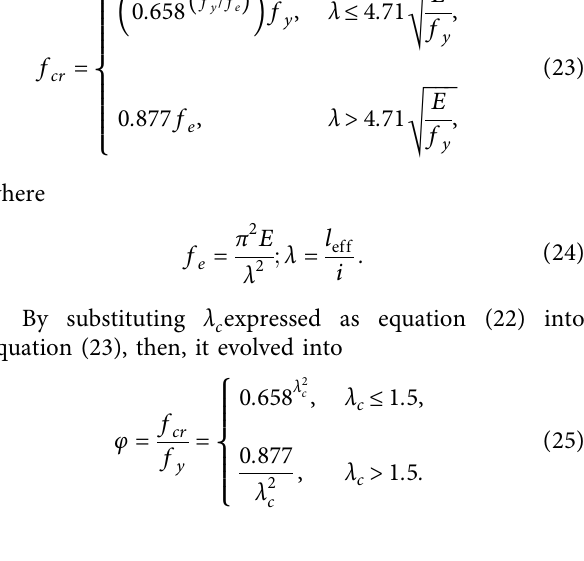
Figure 10: The curve of λ n,p versus strength reduction coefficient